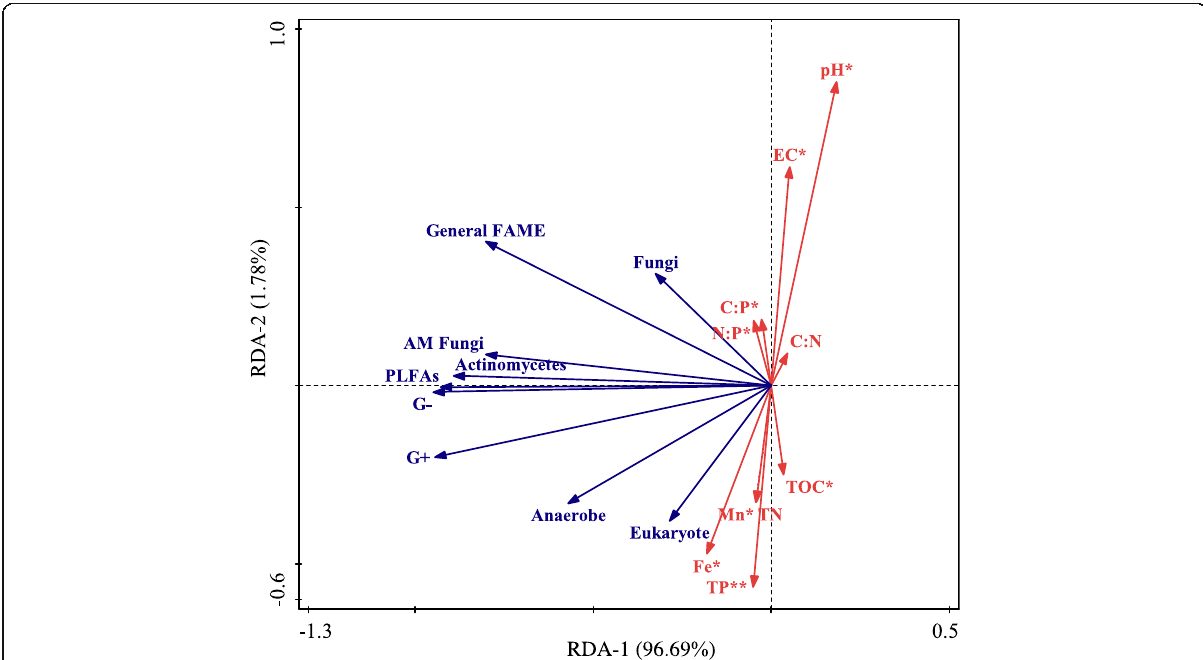
Fig. 3 Redundancy analysis (RDA) ordination biplot for the relationship between soil microbial communities and environmental variables